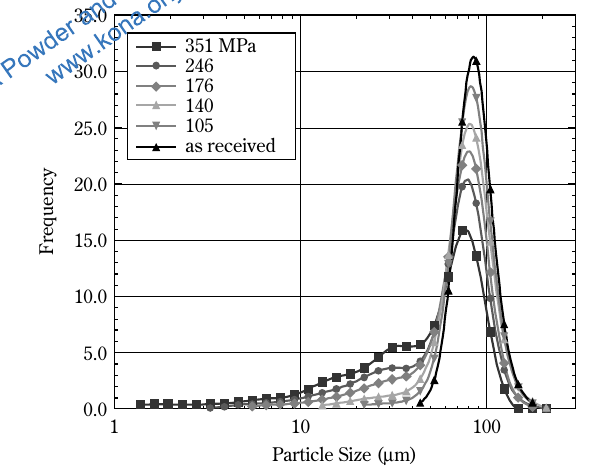
Fig. 4 Change in particle size distribution of glass beads as a result of compaction.